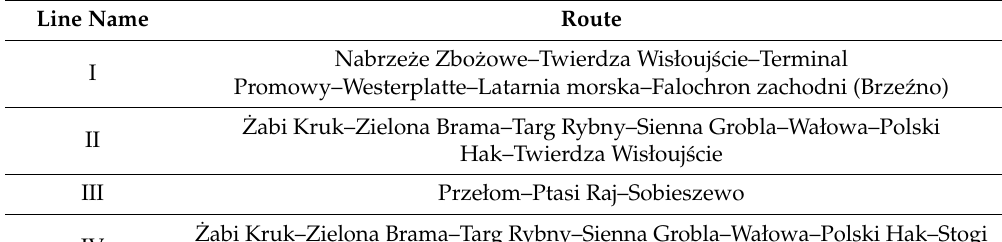
Table 2. Routes of the proposed water tram lines in Gda´nsk. Data from [47].